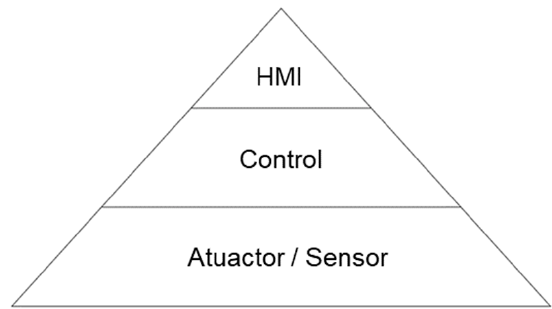
Figure 4. Established automation layers.